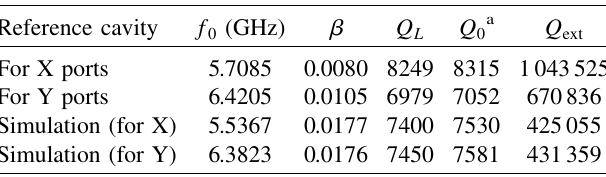
TABLE II. The rf measurement results of reference cavities (measurement before installation).